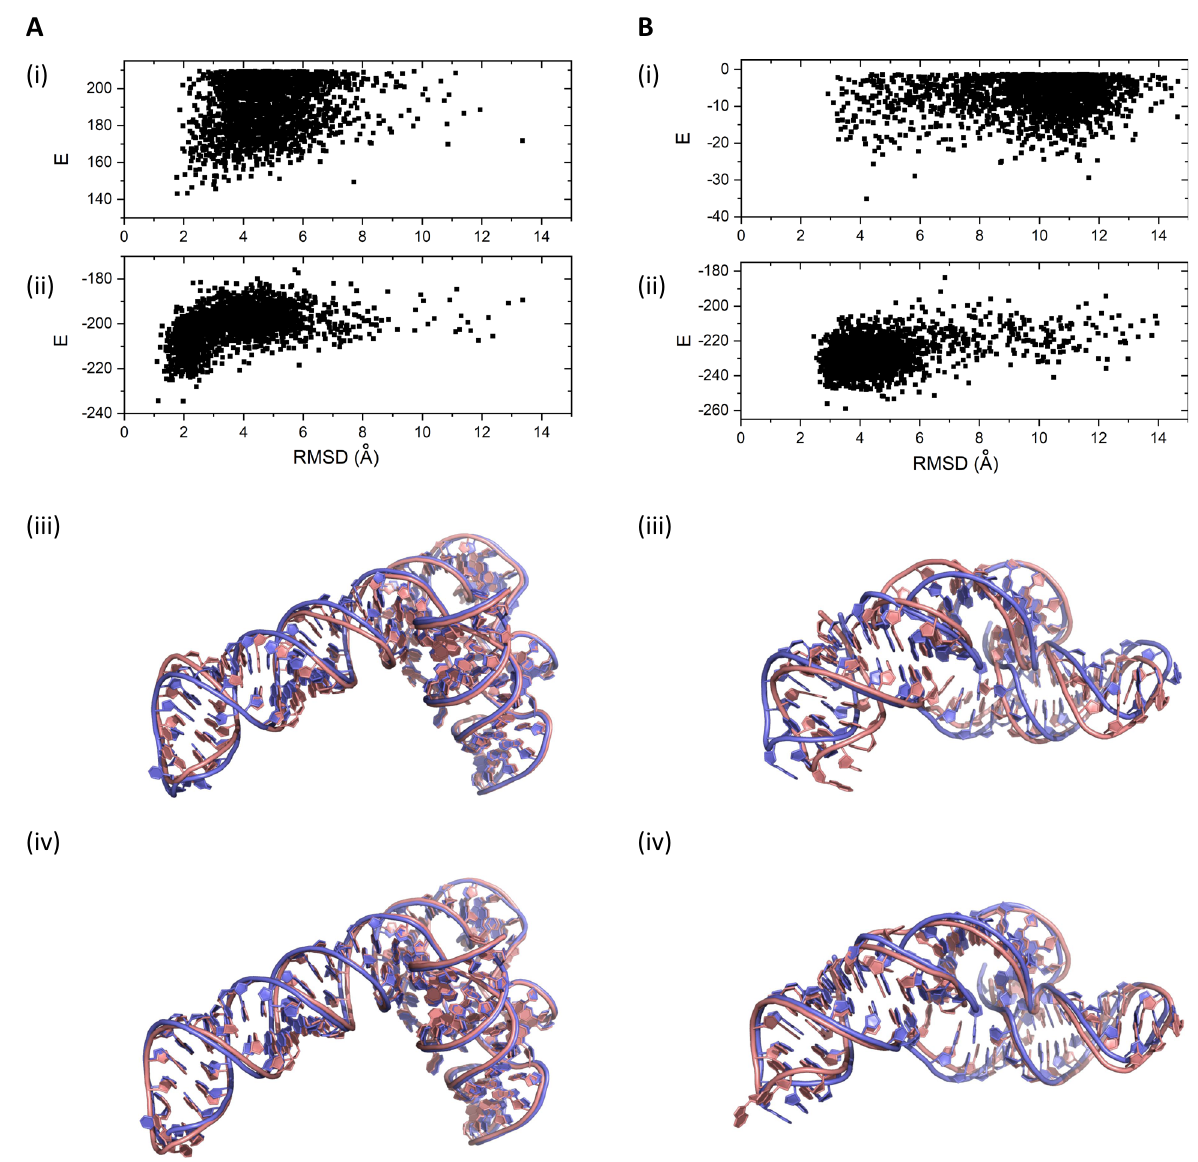
Fig. 5 Comparison of representative FARFAR2 models and their re fi nement by BRiQ. Energy versus RMSD values of the conformations sampled by (i) FARFAR2, (ii) re fi nement of FARFAR2 conformations by BRiQ for A RNA Puzzle 4 and B RNA Puzzle 18. Structure alignment of native (blue) to the best in top 1% predicted models by FARFAR2 (iii) and BRiQ re fi nement (iv) in the bottom